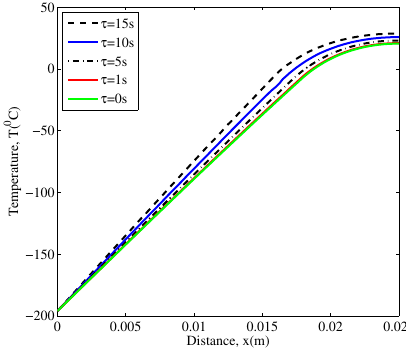
Figure 3. Temperature profile at t = 800 s for the value of τ = 15 s , τ = 10 s , τ = 5 s , τ = 1 s , τ = 0 s .